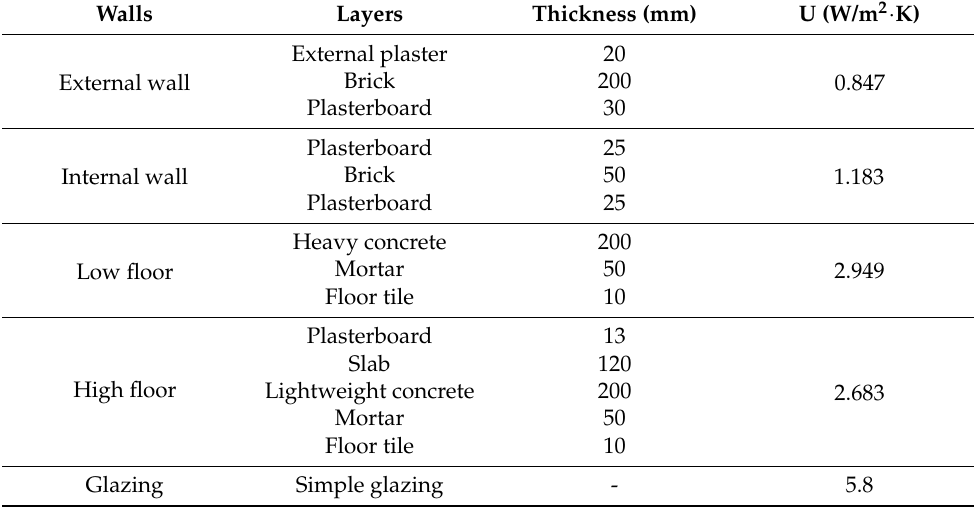
Table 2. The conventional building envelope.